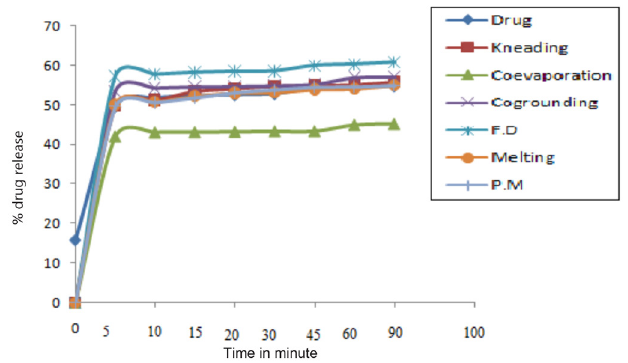
TABLE III - Taste evaluation of the